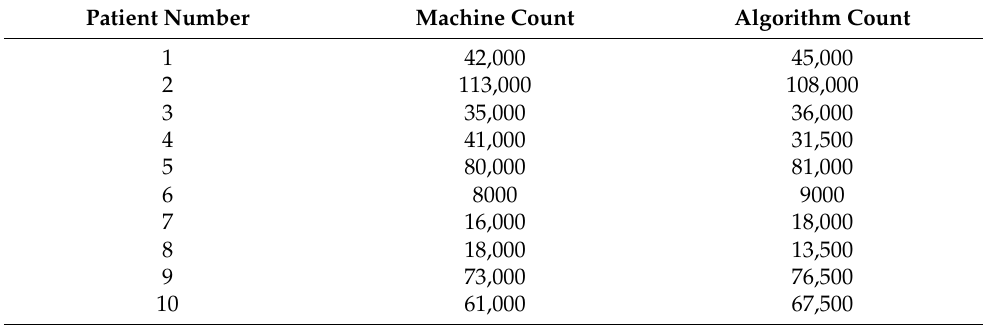
Figure 6. The sample results of the intermediate steps in the platelet detection process: ( a ) Original 100x RGB image, ( b ) Green component, and ( c ) Platelet detection. Table 2. Platelet counts per microliter of blood.